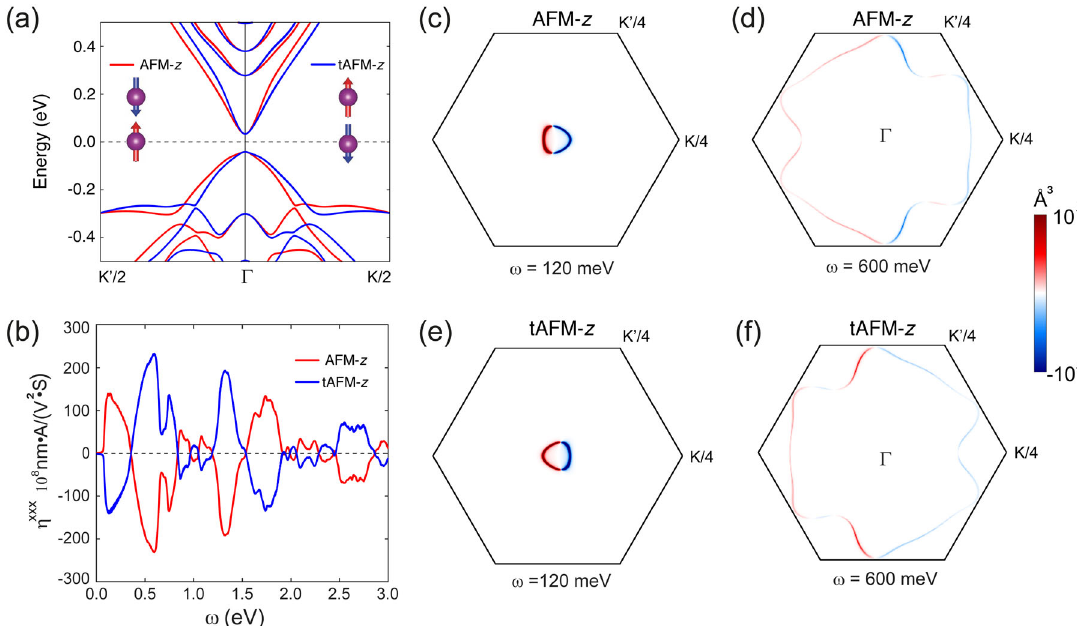
Fig. 2 Magnetic injection current (MIC) in bilayer MnBi2Te4 with magnetic ordering in AFM-z ( ↑↓ ) and time-reversed AFM-z (tAFM, ↓↑ ). a Band structure of bilayer AFM- z and tAFM- z MnBi 2 Te 4 with spin – orbit coupling taken into account. b Frequency-dependent magnetic injection current response of bilayer AFM- z and tAFM- z MnBi 2 Te 4 . c – f Microscopic distribution of MIC f mn Δ a valence band and bottom conduction band at different frequencies of 120 and 600 meV in bilayer AFM- z and tAFM- z MnBi 2 Te 4 . It shows that MIC can be switched between two time-reversed magnetic orders AFM- z ( ↑↓ ) and tAFM ( ↓↑